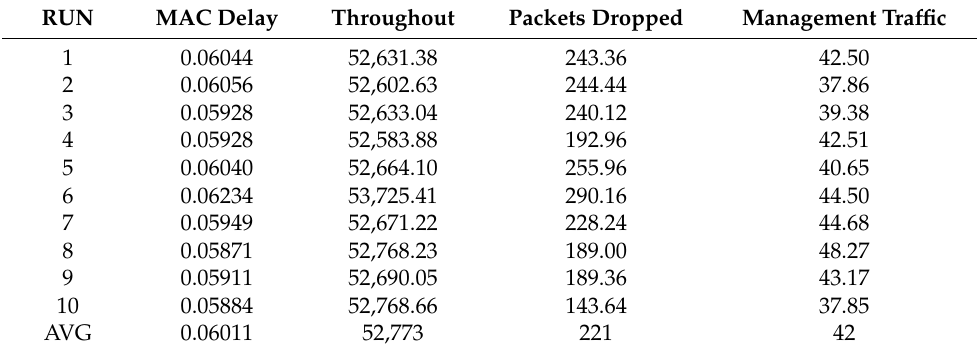
Table 17. Fire Station Scenario Tabu Search.